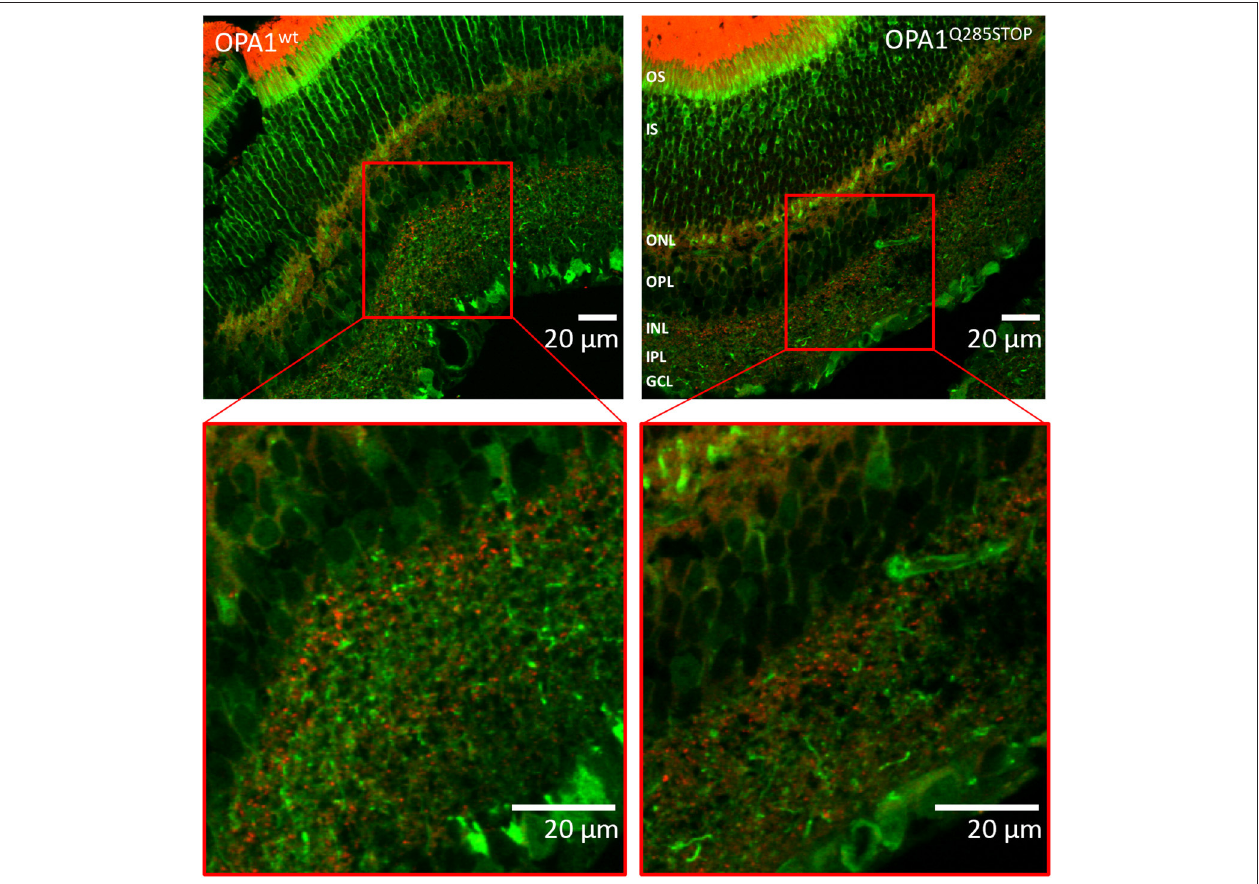
FIGURE 6 | Confocal images of transgenic OPA1wt and OPA1 Q285STOP mouse retina sections expressing LC3-GFP and RedMIT Representative images of the retina from the RedMIT-GFP-LC3-OPA1 + / + (Left) and the RedMIT-GFP-LC3-OPA1 Q285STOP (Right) mice sections show autophagosomes with GFP-tagged LC3 and RedMIT tagged mitochondria. Sections were cut at 10 µ m and visualized using a Zeiss LSM 700 inverted confocal microscope with a plan-Apo 63x NA 1.4 oil-immersion objective. Red boxes indicate the area magnified in each inset. RedMIT were observed from the ONL toward the IPL in both OPA1 wt and OPA1 Q285STOP . No difference in GFP-LC3 or mitochondrial mRFP is seen between OPA wild type and mutant (zoomed insets, bottom panels). In particular, no colocalization was observed between GFP-LC3 and RedMIT in both OPA1 wt and OPA1 Q285STOP (Pearson correlation coefficient of + 0.22 and − 0.16; n = 4). Scale bars: 20 µ m OS, outer segments; IS, inner segments; ONL, outer nucleus layer; OPL, outer plexiform layer; INL, inner nucleus layer; IPL, inner plexiform layer; GCL, ganglion cell